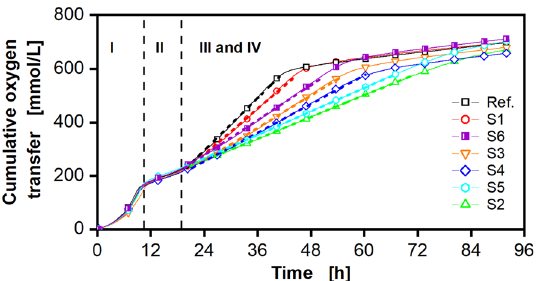
Figure 4. Cumulative oxygen transfer data of a clone library with GFP-secreting P. pastoris Mut S strains cultivated in a 48-round well microtiter plate. The integral of the OTR (cumulative oxygen transfer) of the cultures shown in Fig. 3 is depicted. For clarity, only every 20th data point is displayed. The four cultivation phases (I-IV) are indicated by vertical dashed lines as in the previously shown data set (Fig. 3). The slope of the cumulative oxygen transfer was determined by a linear fit of phase III (drawn as dashed line in the corresponding color). The slope values are summarized in Supplementary Table